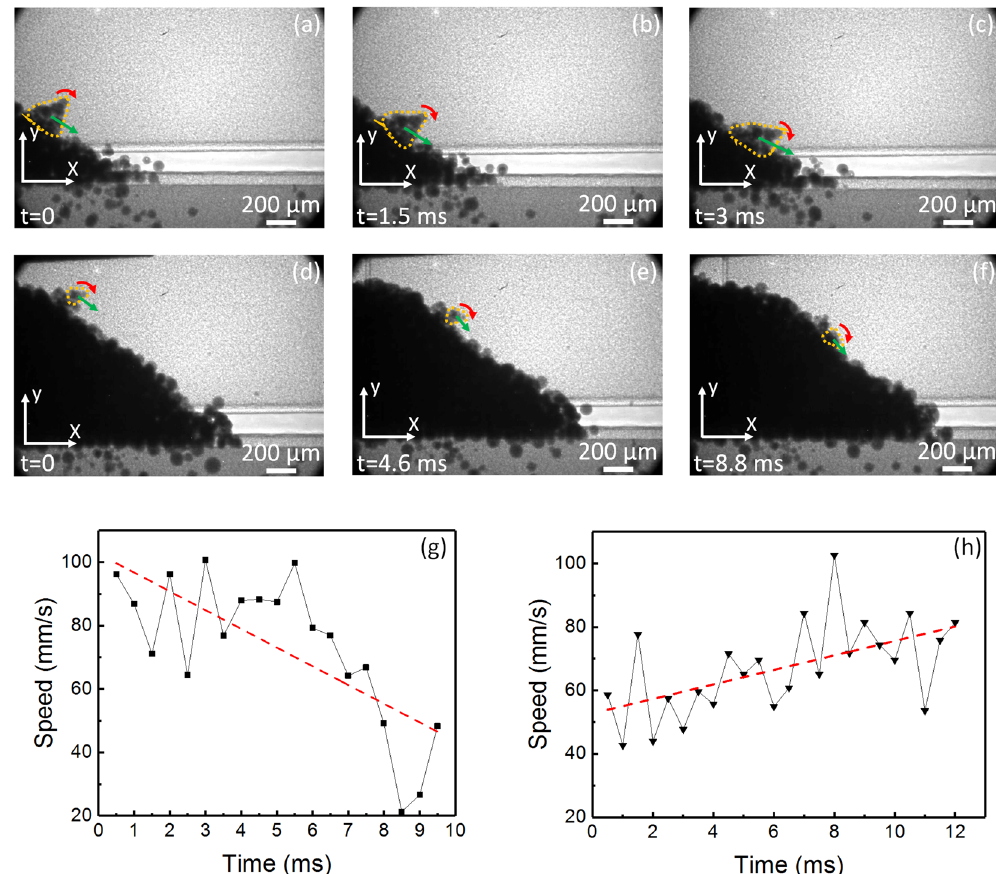
Figure 6. Dynamic evolution of powder clusters tracked on the surface of the slope during the spreading of 316 L stainless steel powder with an average particle diameter of 67 µ m. ( a – c ) Dynamic x-ray images showing the position and evolution of the soft powder cluster “A”. ( d – f ) Dynamic x-ray images showing the position and evolution of the hard powder cluster “B”. The yellow dotted line highlights the cluster’s boundary. The green line indicates the current translational trajectory. The red line indicates the current rotational trajectory. The position was tracked with reference to the origin of the coordinate system in each picture. ( g ) The speed versus time for cluster “A”. ( h ) The speed versus time for cluster “B”. The red dashed line is the linear fitting of each graph. The cluster “A” presented an average flow speed of 73 mm/s with a standard deviation of 23 mm/s. The cluster “B” presented an average flow speed of 67 mm/s with a standard deviation of 15